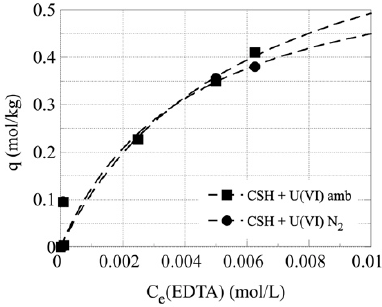
Figure 7. Sorption data and fitted Langmuir isotherms obtained for the “EDTA” sorption by C-S-H solids under ambient conditions and N 2 -atmosphere.